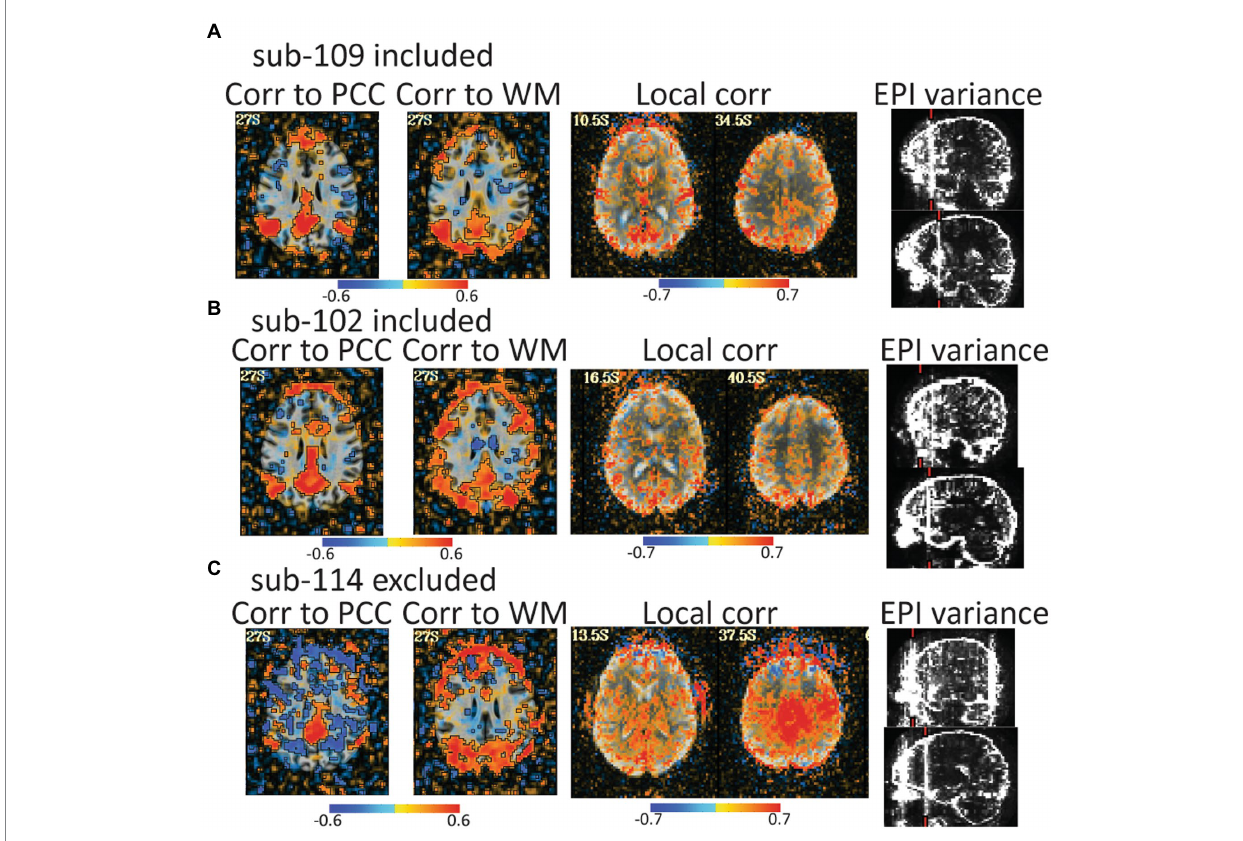
FIGURE 6 Automated QC image from 3 rest data study subjects with low head motion (only 4%–6% of volumes censored). An atlas-based posterior cingulate (PCC) ROI is calculated and the correlation maps (r values), should highlight some default mode network (DMN) connections. Too much correlation between a white matter (WM) ROI and gray matter can be concerning. Local correlations are the correlations of each voxel to surrounding voxels in a 2 cm sphere and can highlight scanner artifacts. EPI variance line warnings highlight lines of high variance that might be artifacts. (A) sub-109 has a plausible DMN from the PCC seed, no excessive correlations to white matter, no non-anatomical local correlations, and the variance warnings were checked with instacorr and did not show pervasive issues after preprocessing. (B) sub-102 was typical for these data. The DMN is present, but not as clean, there are more WM correlations in and out of the brain, and EPI variance warnings showed some issues with instacorr , but not enough to reject. If typical subjects in this dataset were cleaner, we might have rejected sub-102. (C) sub-114 is a clear rejection with non-anatomical anticorrelations to the PCC, large artifacts in WM correlations, a large local correlation, and EPI variance warnings paired with concerning artifacts visible with instacorr